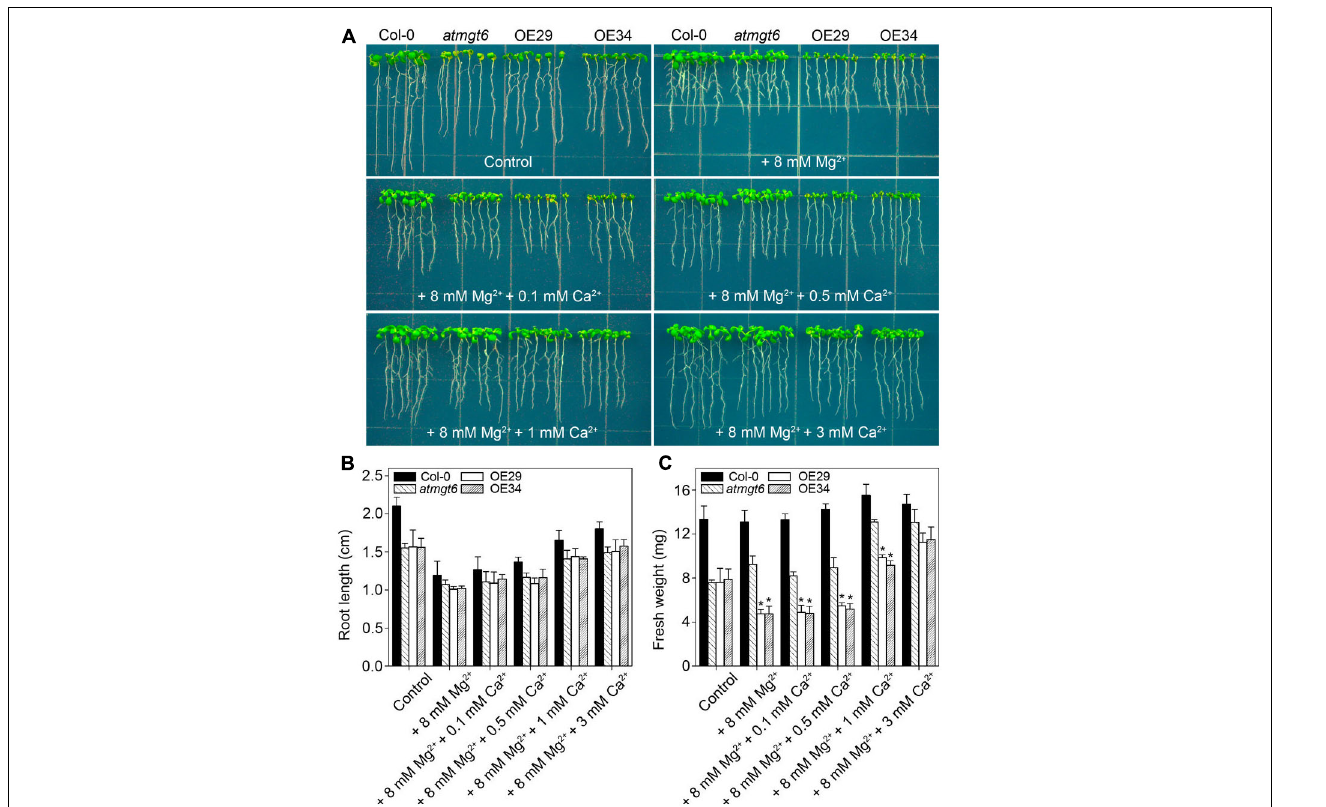
FIGURE 6 | Effects of high Ca 2 + additions on the growth of atmgt6 and transgenic OsHKT2;4 -overexpression atmgt6 lines in the Mg 2 + -abundant medium. (A) The growth of Col-0, atmgt6 and two transgenic OsHKT2;4 overexpression atmgt6 lines (OE29 and OE34) in 1/6 MS (Control) and the Mg 2 + -abundant medium (1/6 MS with extra 8 mM Mg 2 + , referred to as “+8 mM Mg 2 + ” in the figure) containing different extra Ca 2 + concentrations. After planted in 1/2 MS medium for 3 days, Col-0, atmgt6 , OE29, and OE34 were transferred to the 1/6 MS medium (containing a basal 0.25 mM Mg 2 + and 0.5 mM Ca 2 + ), or the Mg 2 + -abundant medium with 0, 0.1, 0.5, 1, or 3 mM extra Ca 2 + . Plants were photographed after growing for another 7 days. Quantitative analyses of primary root length (B) and whole-plant fresh weight (C) of Col-0, atmgt6 , OE29, and OE34 under the conditions described in (A) . Six independent 10-day-old seedlings of each genotype were gathered as one biological repeat for root length and fresh weight measurement. Data are represented as the mean ± SD, n = 3, in which n is the number of biological repeat. Asterisks indicate statistically significant differences compared with atmgt6 (Student’s t -test, ∗ P <